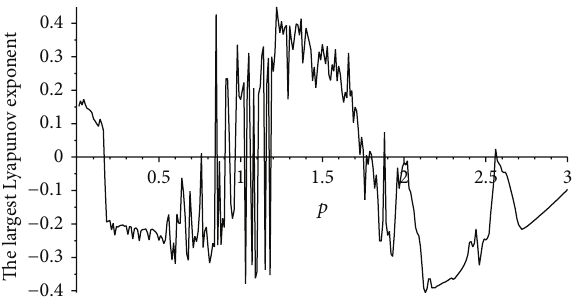
Figure 5: The largest Lyapunov exponents for System (2) with 𝑝 varying from 0 to 3.